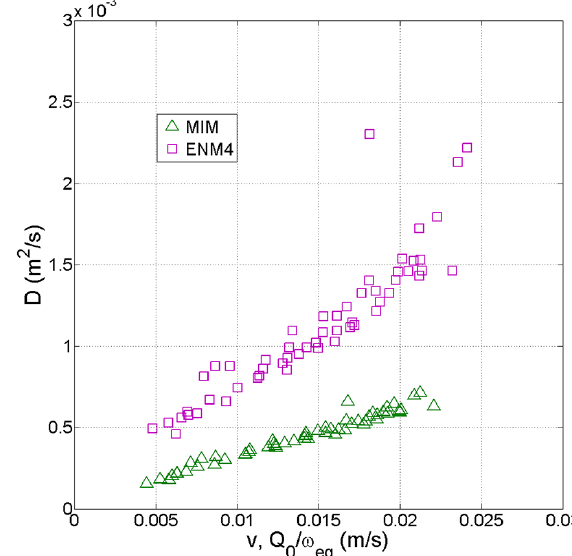
Figure 12. Velocity ν (ms − 1 ) as function of the injection flow rate Q 0 (m 3 s − 1 ) for MIM and ENM4. Note that for MIM, the ν is deter- mined assuming the length of medium equal to the length of main path ( L = 0 . 601m). Instead for the ENM4, the velocity is deter- mined dividing Q 0 for the equivalent area ω eq .